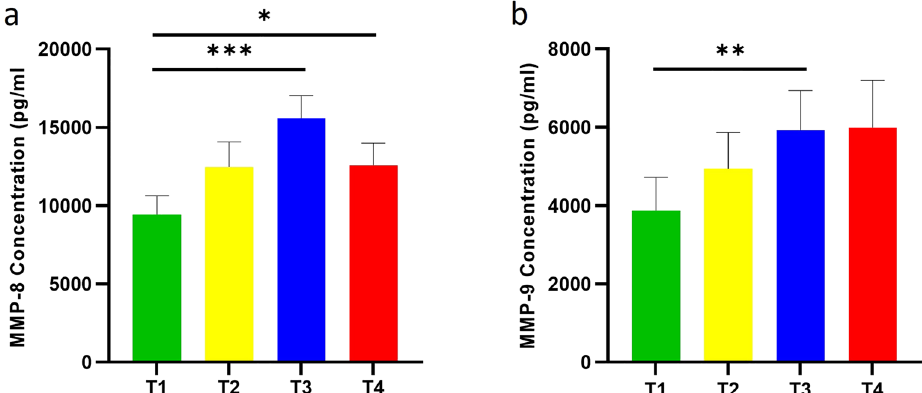
Figure 4. Graphs showing the levels of matrix metalloproteinase-8 (MMP8) ( a ) and matrix metalloproteinase-9 (MMP9) ( b ), as measured by ELISA (Enzyme-linked immunosorbent assay), in unstimulated whole mouth saliva of 16 participants at four time-points. T1 baseline (before placement of orthodontic appliance), T2 1 h after placement of orthodontic appliance, T3 1 week after placement of orthodontic appliance T4 end of the alignment. Data were analysed by repeated measures ANOVA; *p < 0.05; **p < 0.01; ***p <